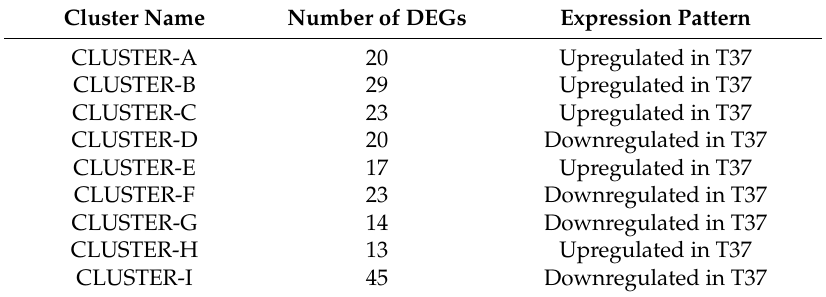
Table 1. Number of differentially expressed genes (DEGs) and the expression pattern within individual clusters.